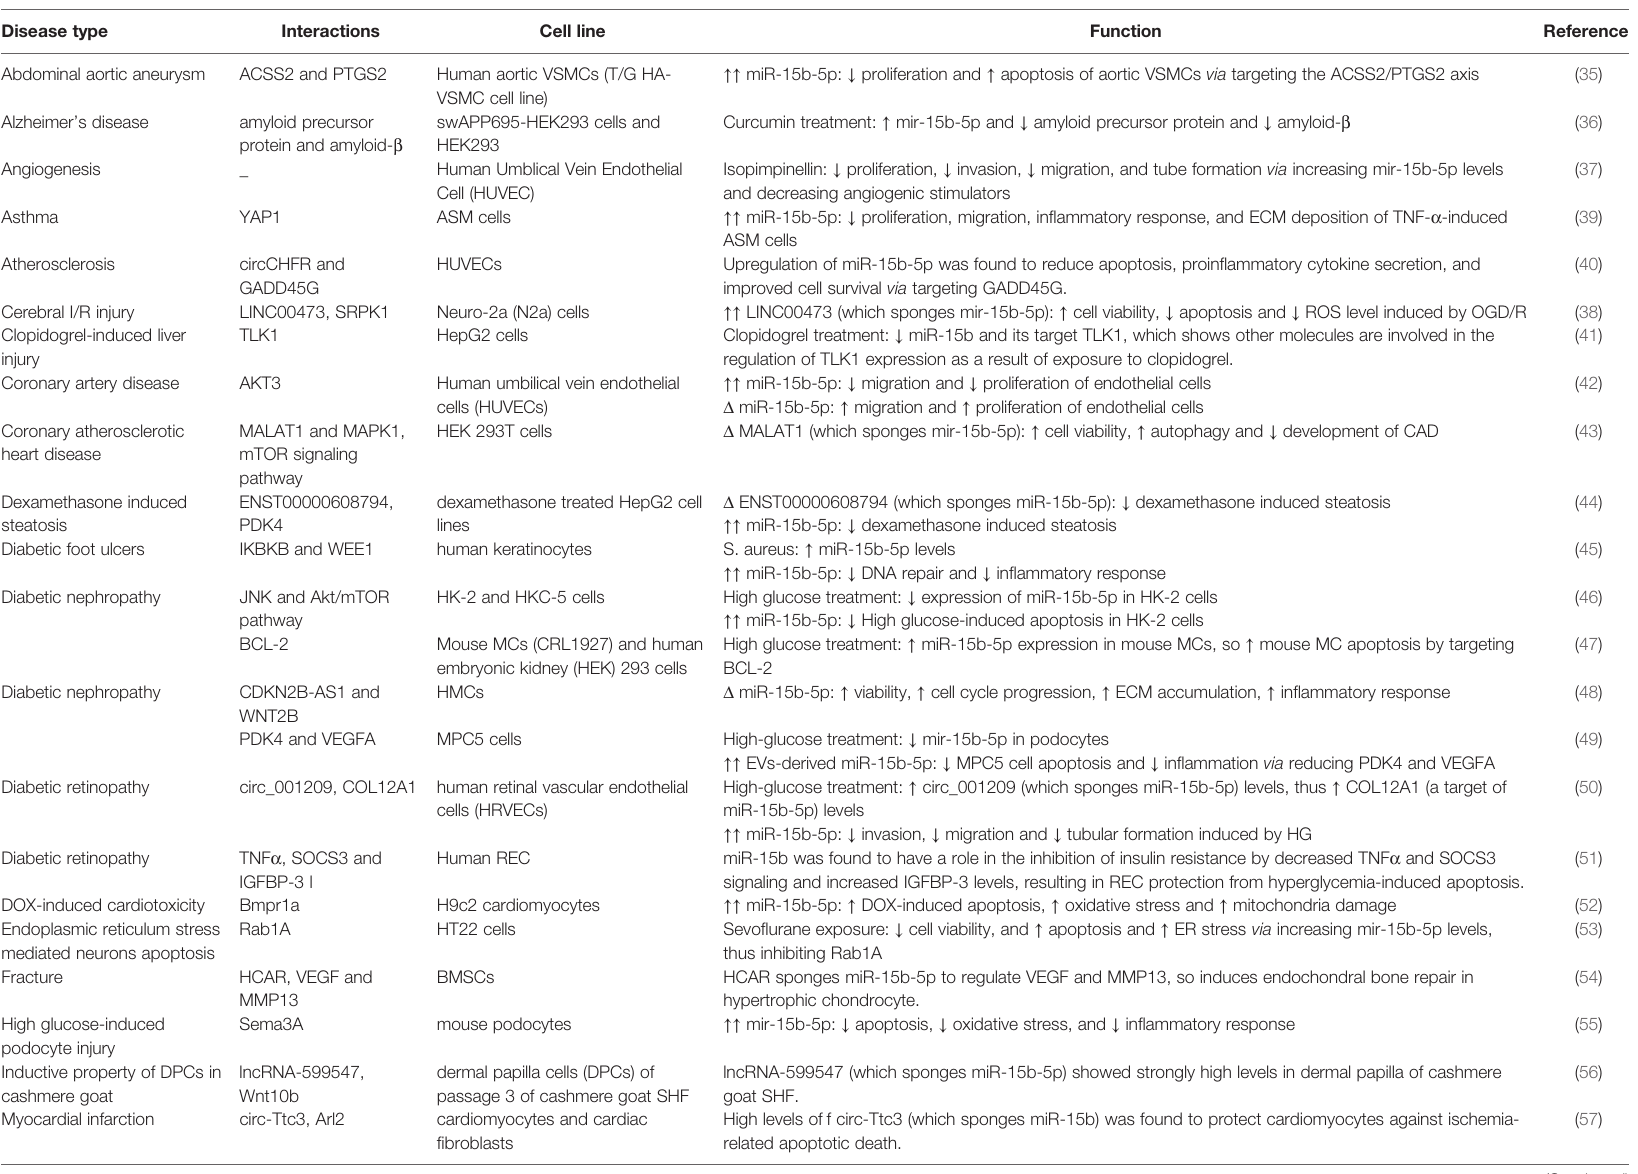
TABLE 4 | Summary of cell line studies on the role of miR-15b-5p in non-malignant conditions ( D , knock-down or deletion; DOX, doxorubicin; H2S, Hydrogen sul fi de; HG, High glucose; SHF, secondary hair follicle; ER, endoplasmic reticulum; EVs, extracellular vesicles). Disease